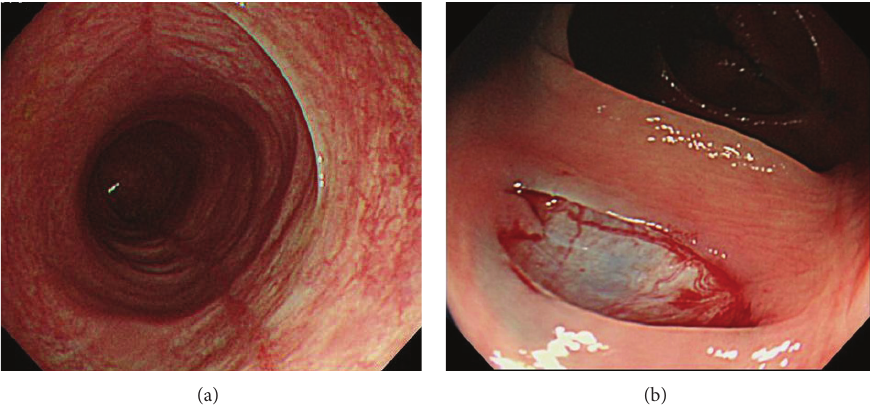
Figure 3: (a) A second colonoscopy was performed two months after the first colonoscopy. The liner ulcers dramatically tended to be healed. (b) Mucosal tear occurred when biopsy specimen was taken from the ascending